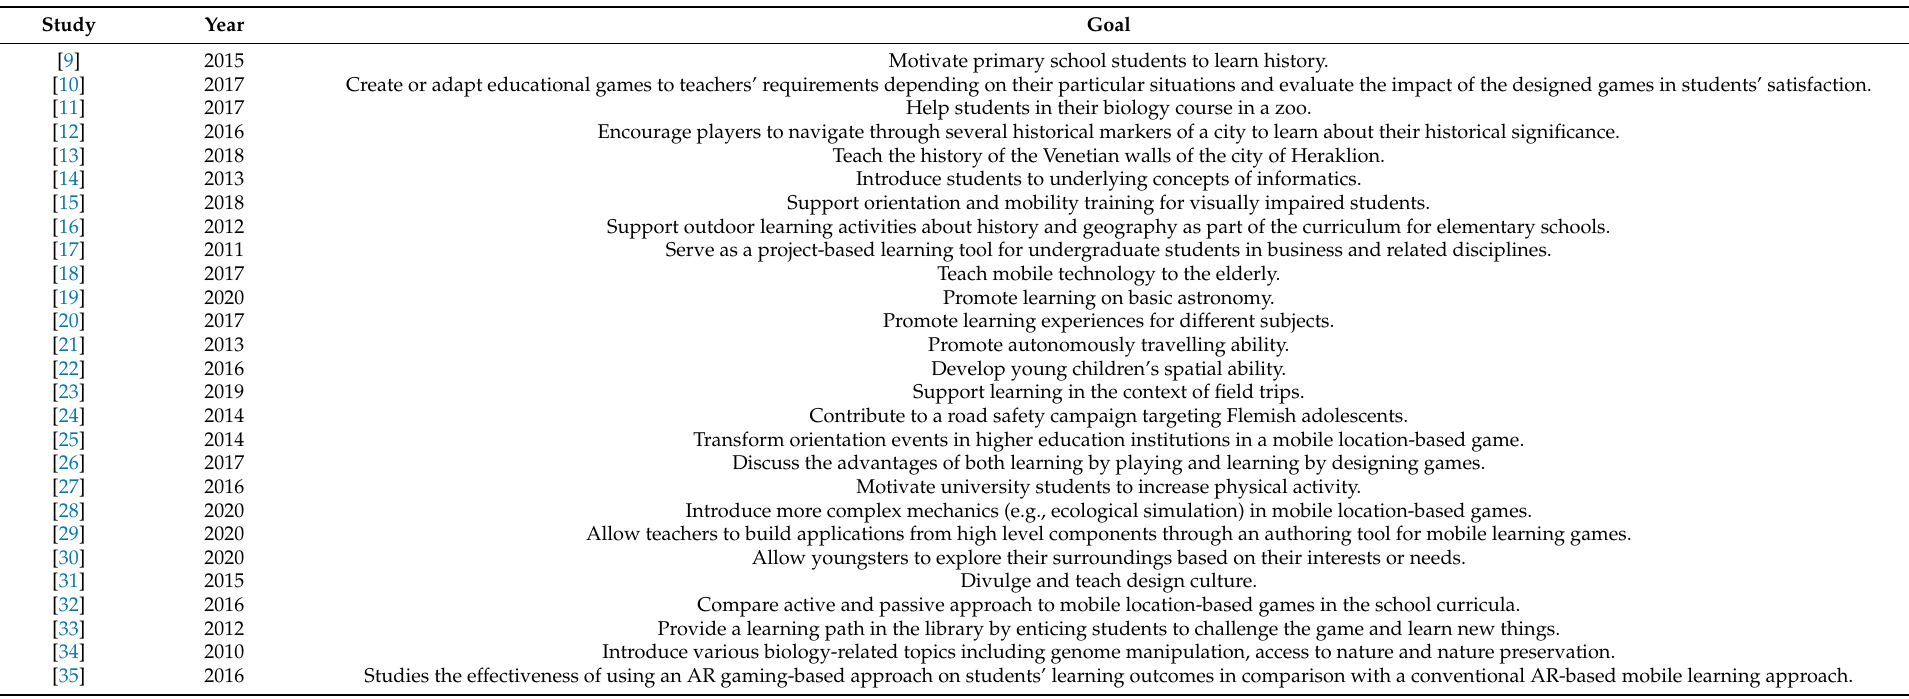
Table 3. Purpose and goals of the studies ( n =